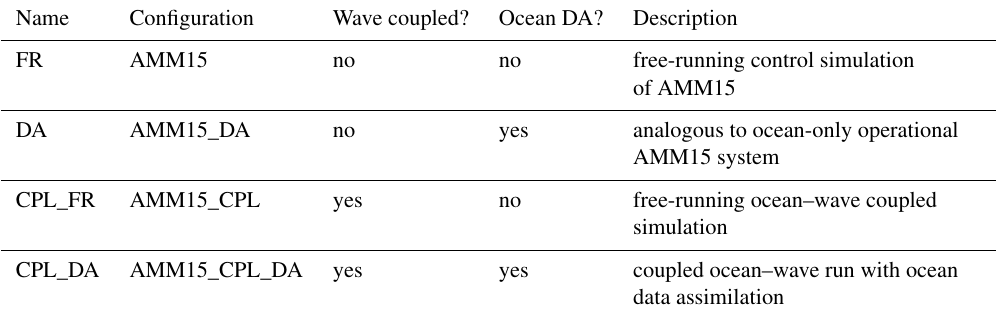
Table 1. Overview of simulation experiments